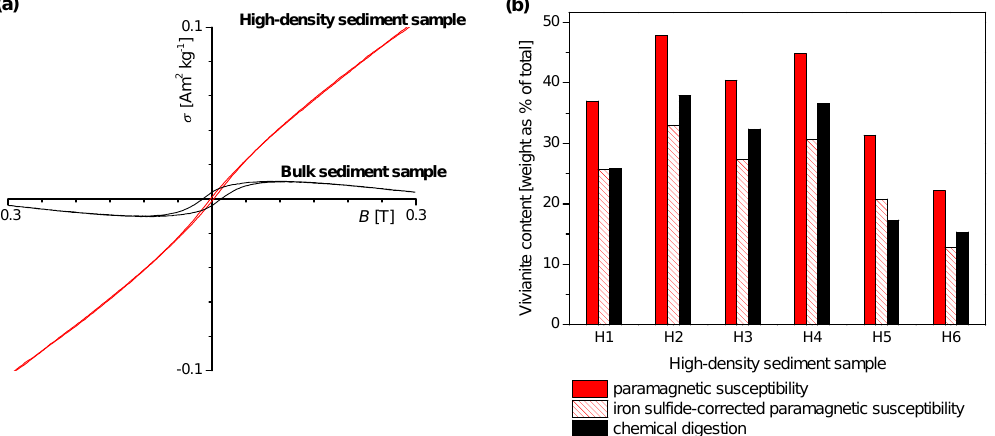
Figure 5. (a) Magnetisation σ [Am 2 kg − 1 ] vs. magnetic field B [ T], peak value B = 0 . 3T of a high-density sample, and a bulk sediment sample from 10cm sediment depth. The positive slope of the high-density sample at higher magnetic fields indicates enrichment with paramagnetic material after heavy-liquid separation. (b) Variations in vivianite content (expressed as % weight of the sample) in each of six high-density samples, based upon paramagnetic susceptibility, iron sulfide-corrected paramagnetic susceptibility and chemical digestion.